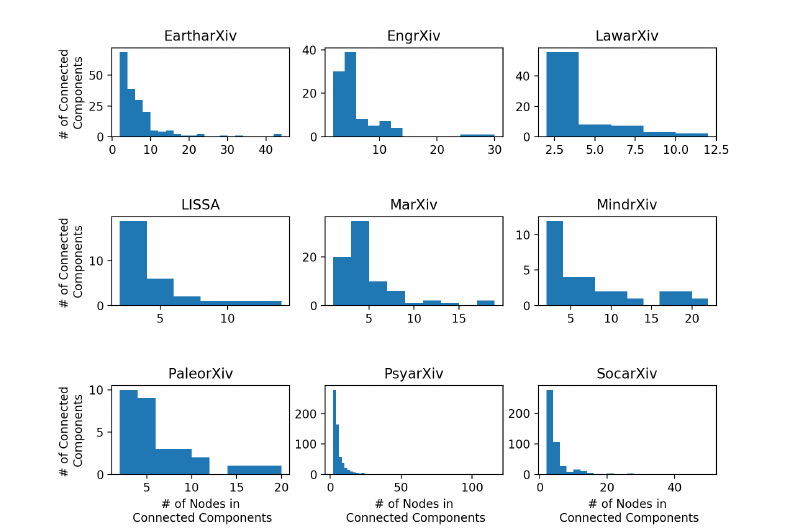
Figure 4. Distribution of connected components (excluding the largest) amongst the nine COS systems. Note that both X and Y axes are different for each panel, but the bin width (along the X axis) is fixed at 2